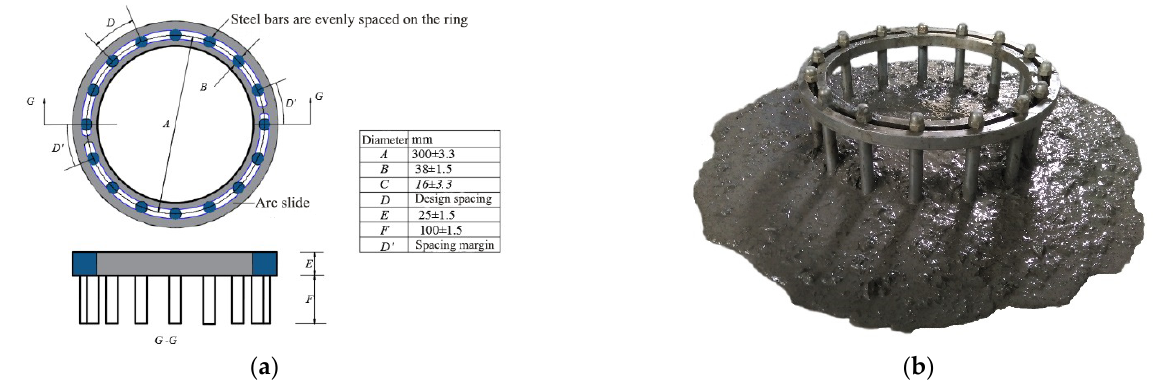
Figure 1. Modified J-ring with variable rebar spacing: ( a ) diagrammatic sketch; ( b ) picture. The stability of SCC was evaluated by the static segregation test with an index